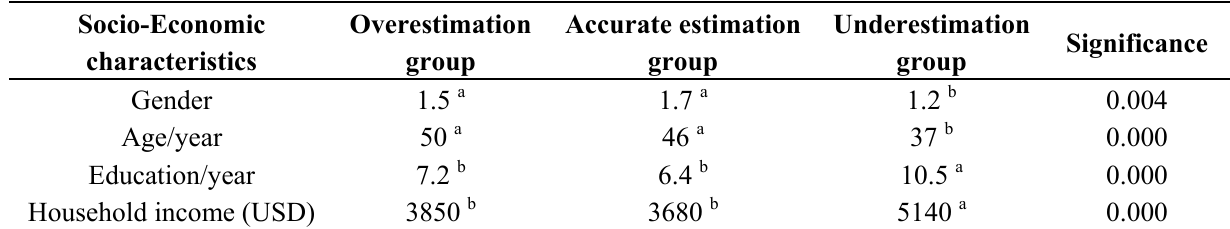
Table 3. Average socio-economic characteristics of estimation groups with total